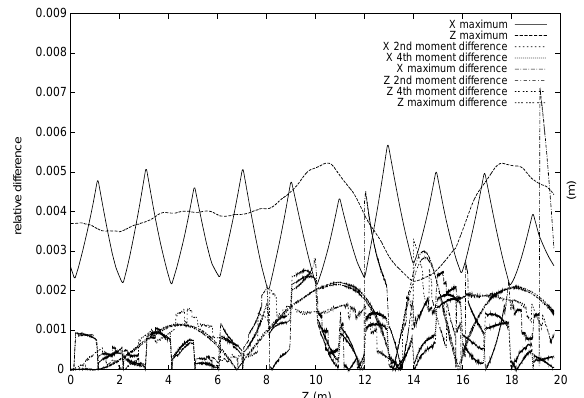
FIG. 12. The relative difference and maximum particle am- plitude as a function of position with double-length reference transport